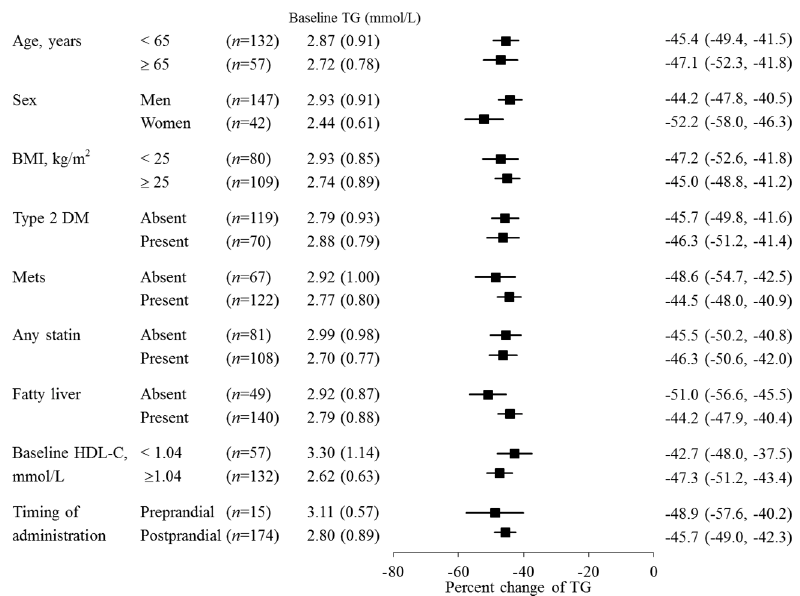
Figure 3. Subgroup analysis for percent change of TG from baseline at week 52 (LOCF). Data of percent change of TG are presented as means (95% CI), and data of baseline TG are presented as means (SD). TG, triglyceride; LOCF, last-observation-carried-forward; SD, standard deviation; CI, confidence interval; BMI, body mass index; DM, diabetes mellitus; Mets, metabolic syndrome.